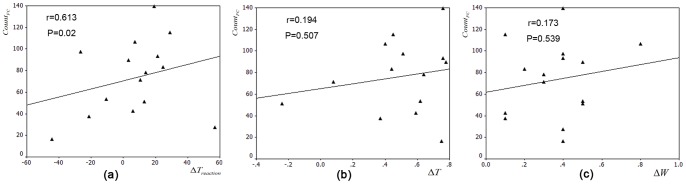
Results of correlation analysis of functional connectivity changes with behavioral performance and physiological changes.(a) Scatter plots of the number of significantly altered functional connectivities () and the increase of executive control reaction time ().Significant positive correlations were found between  and . (b–c) Scatter plots of the number of significantly altered functional connectivities () and the differential rectal temperature (b), weight loss (c), but no significant correlations were found.